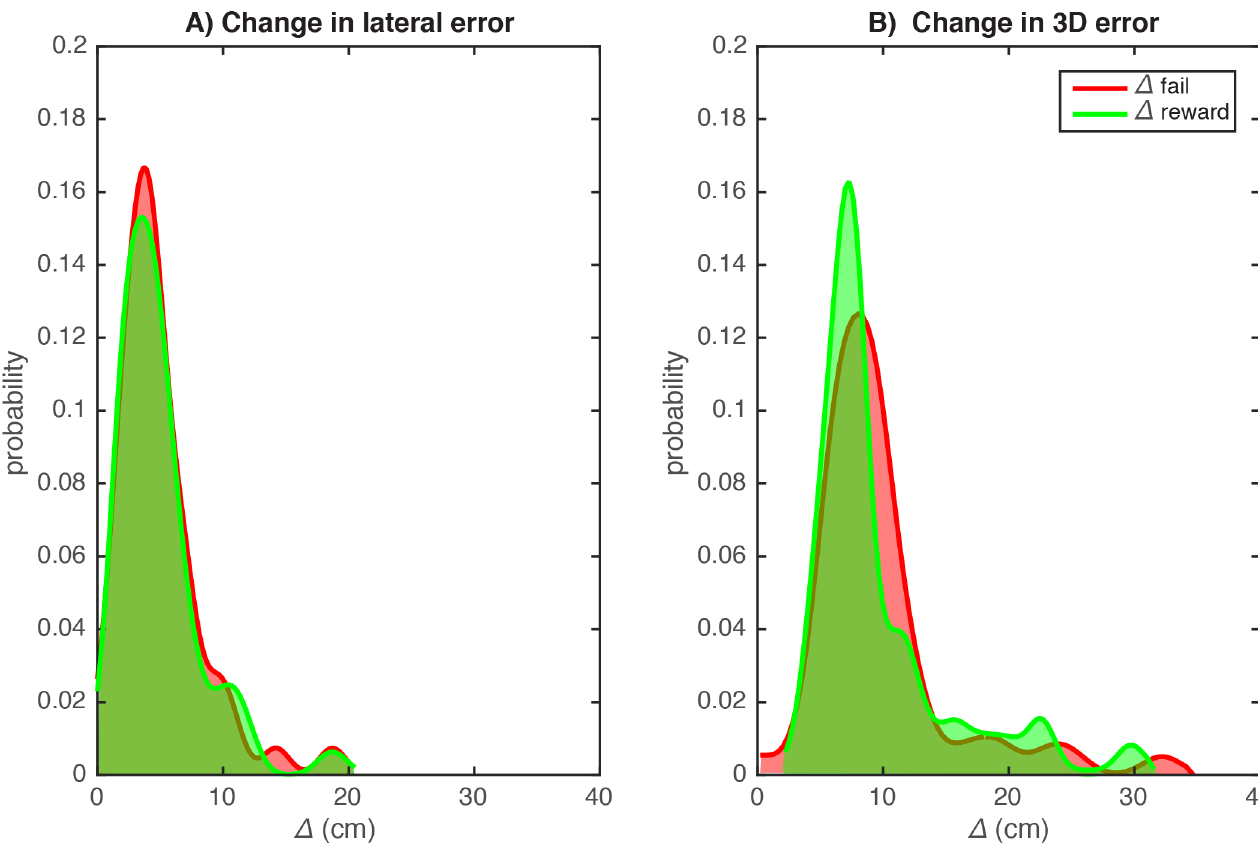
Fig 3. Random reward group, reward only condition. Distribution of trial-by-trial changes in the lateral error following rewarded and non-rewarded trials. A ) Trial-by-trial changes in the lateral error following randomly rewarded trials ( Δ distribution. B ) trial-by-trial changes in the 3D error following rewarded trials were larger than those following non-rewarded trials.